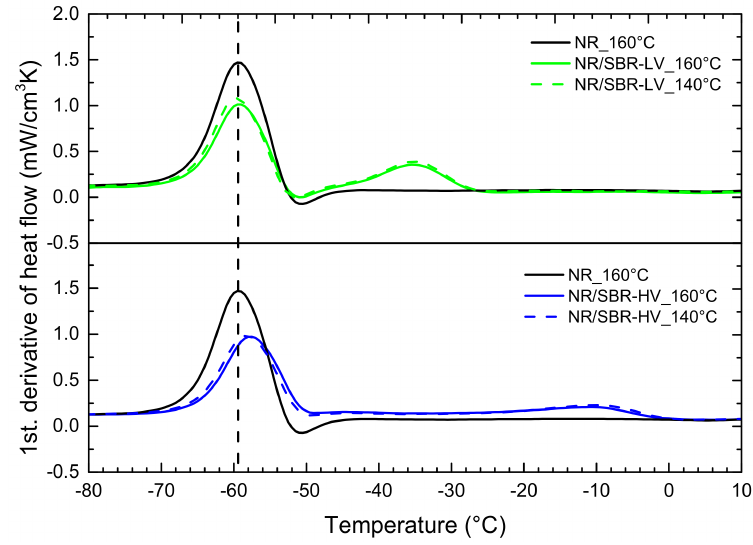
Figure 6. DSC curves (first derivative) of NR/SBR–LV and NR/SBR–HV at curing temperature of 140 and 160 ◦